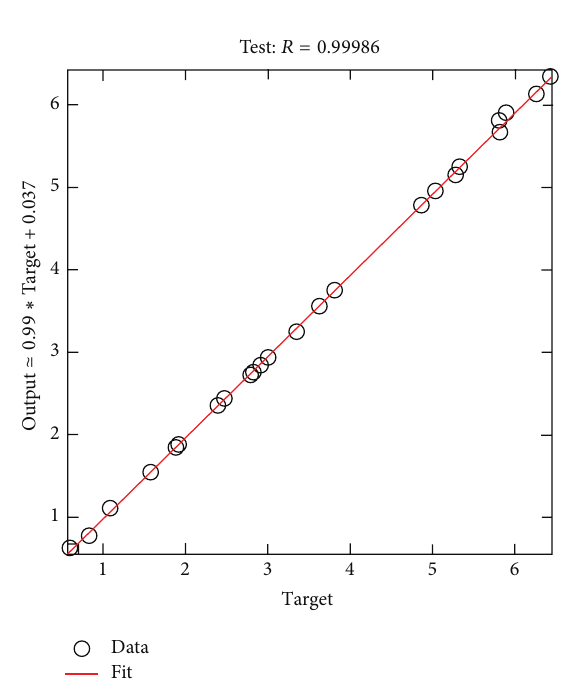
Figure 15: Test correlation